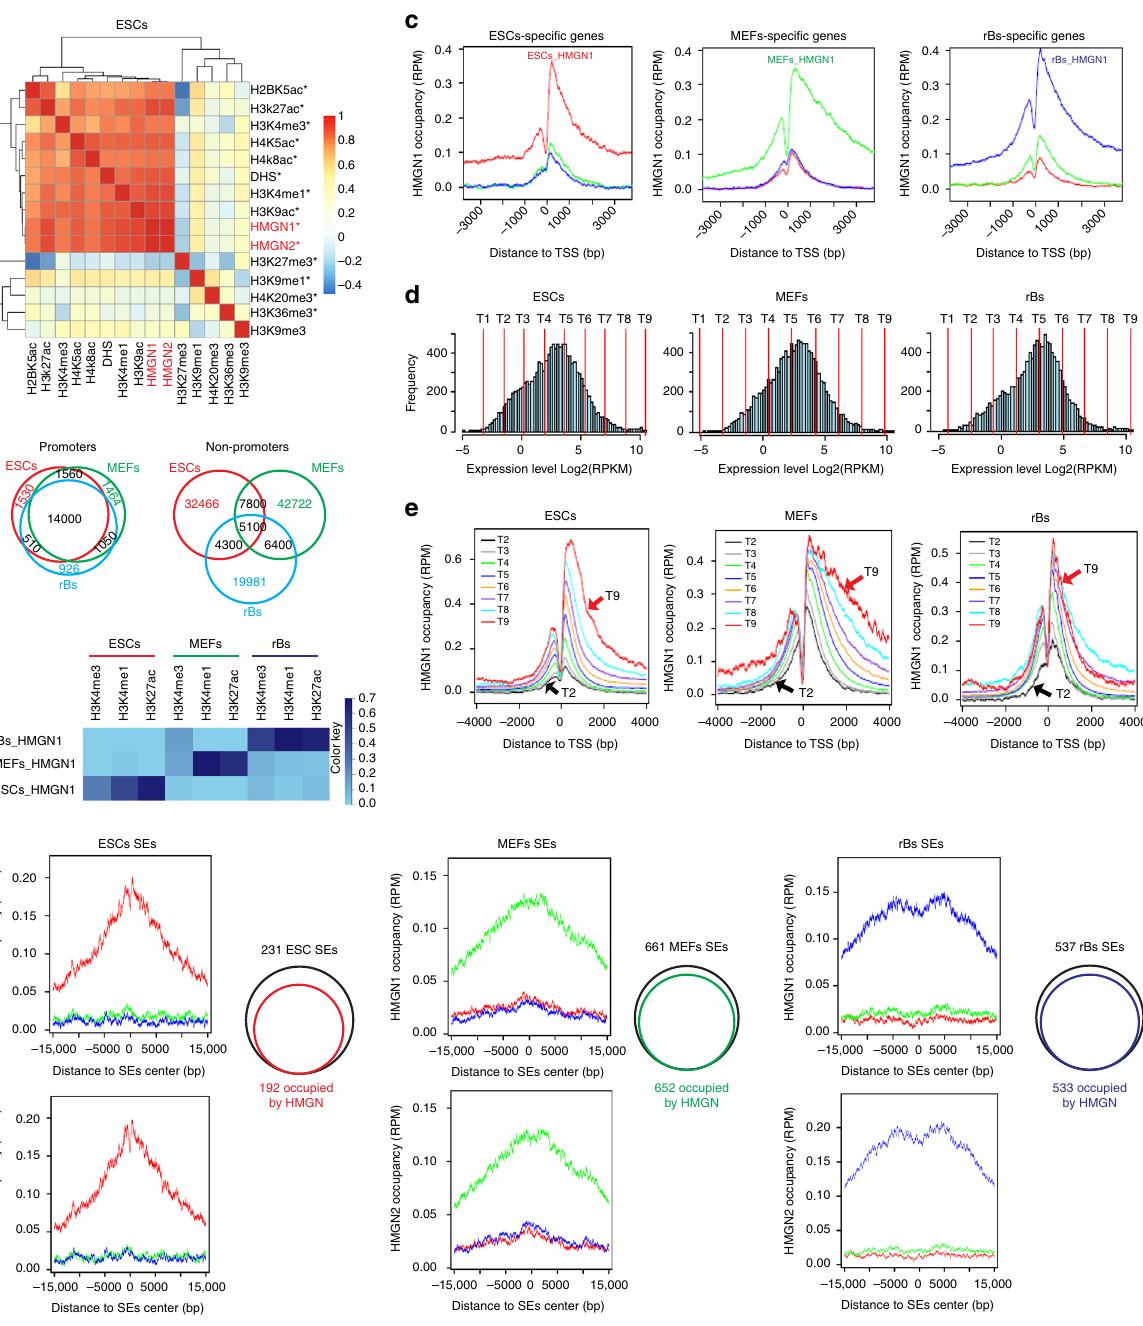
Fig. 1 HMGNs localize to tissue speci fi c chromatin regulatory sites. a Clustering map showing preferential localization of HMGN1 and HMGN2 with epigenetic marks of active chromatin in ESCs. *: data from our experiments. b Coincident HMGN occupancy at annotated promoters, but not at non- promoter regions in MEFs, rBs, and ESCs. c High HMGN1 occupancy at cell-speci fi c expressed genes. d , e HMGN occupancy correlates directly with cell- speci fi c gene expression levels. Genes are sorted into 9 tiers based on expression value ( d ). HMGN1 occupancy at the promoter of each group sorted by expression levels ( e ). f Cell-type-speci fi c co-localization of HMGN1 with histone modi fi cations marking cell-type-speci fi c chromatin regulatory regions. g Normalized average intensity and Venn diagrams showing preferential localization of HMGN1 and HMGN2 at cell speci fi c super-enhancers. All data from at least two biological replicates for each HMGN